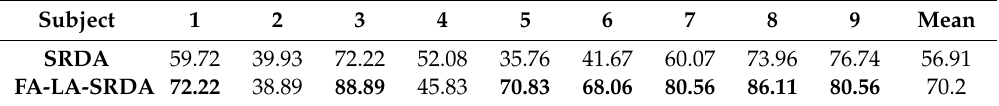
Table 2. Comparison of classification accuracy (%) of spectral regression discriminant analysis (SRDA) and firefly algorithm (FA)- learning automata (LA)-SRDA for data set 2a from the 2008 BCI competition.